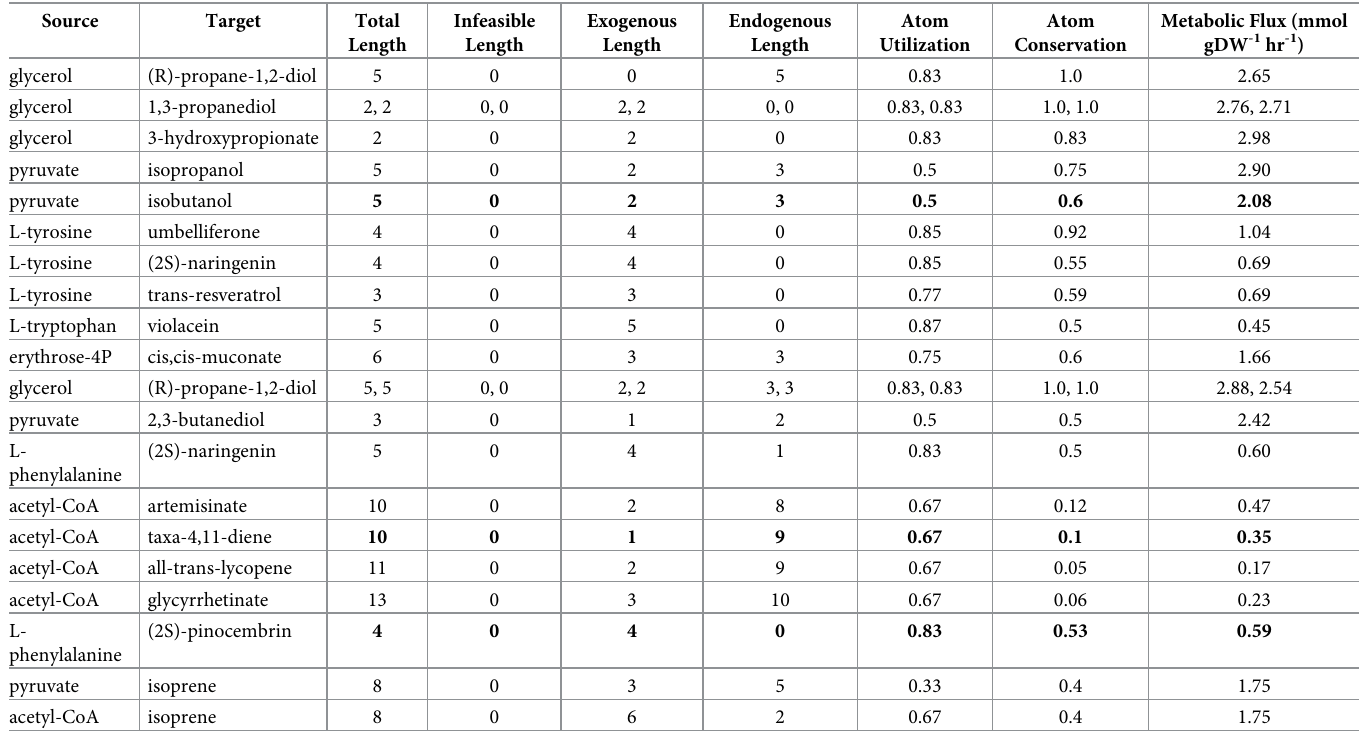
Table 4. Detailed metrics of the biosynthetic pathways discovered by